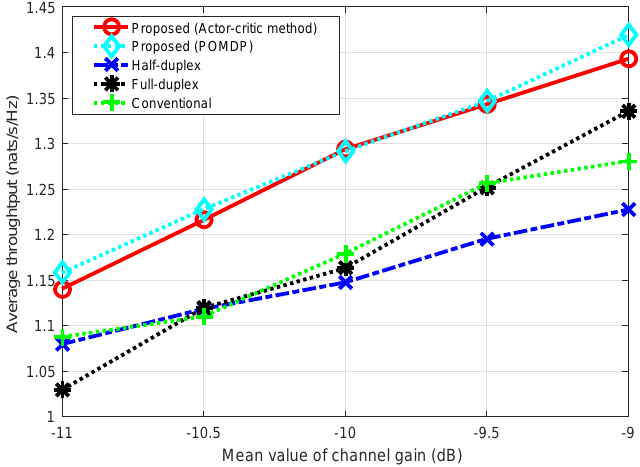
Figure 13. Average throughput according to the mean value of channel gain. The simulation was run for 1000 time slots, and the loop was executed 100